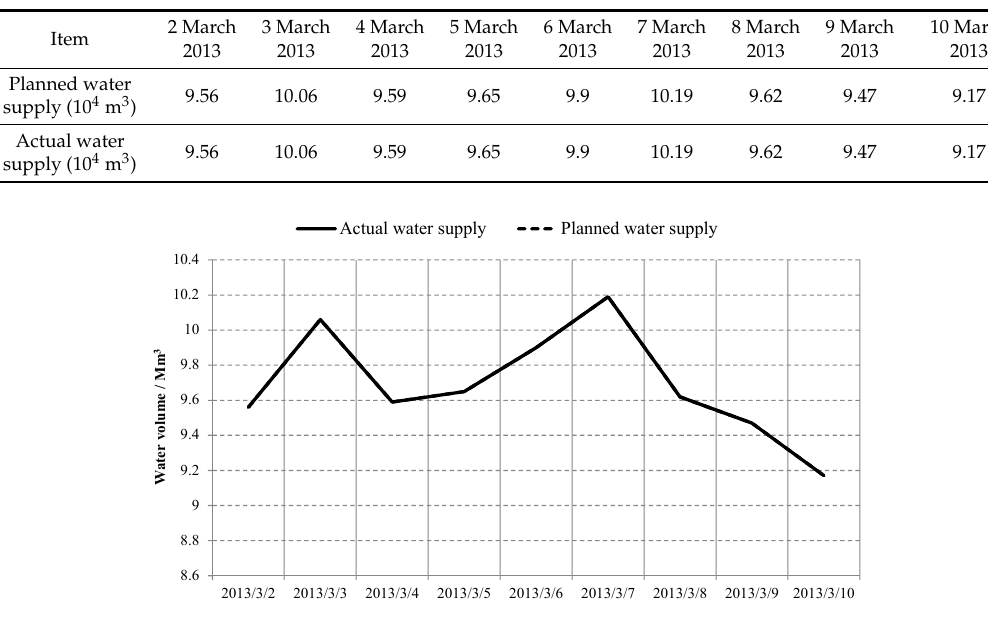
Figure 14. The water flow process of the Shiyan waterworks during the operation period.